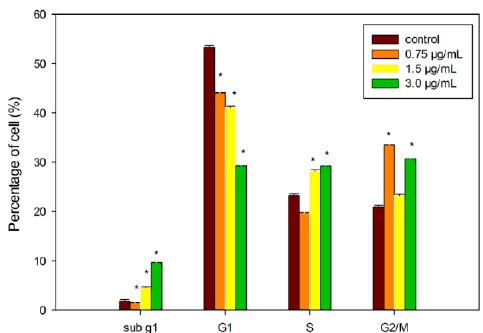
Figure 6. Effect of DET on the cell cycle distribution of HCT116 cells. An accumulation of S-phase cell distribution after treatment with varying concentrations of DET (0.75, 1.5 and 3.0 µg/mL) in HCT116 cells at 24 h. The data expressed as mean ± S.E. from three individual experiments. Asterisks indicate significantly different value from control (* p < 0.001).